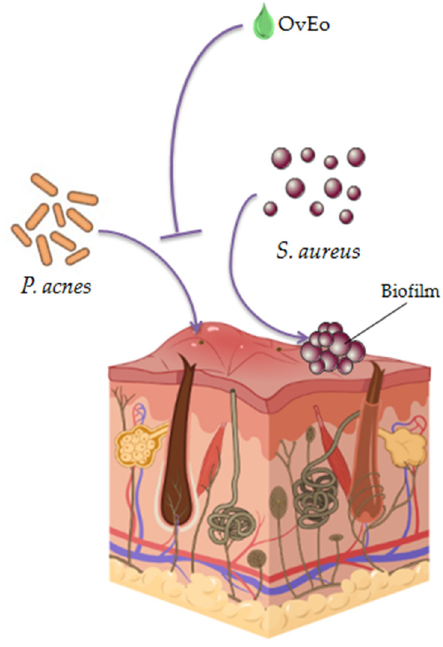
Figure 7. A snapshot of the antiacne effect of